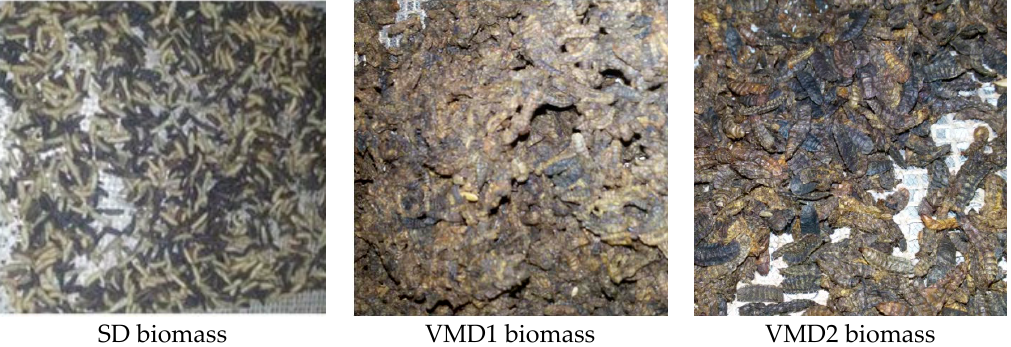
Figure 4. BSF biomass reared on SD and VMD and dried with (VMD1) or without (VMD2) substrate, as it appeared at the end of the drying process.